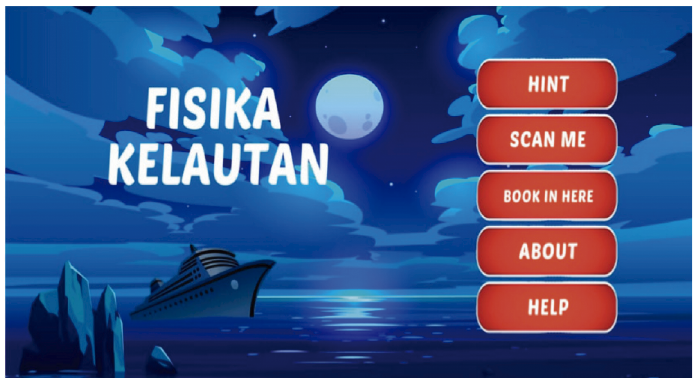
Figure 4. Screenshot of the marine physics concept ARI application